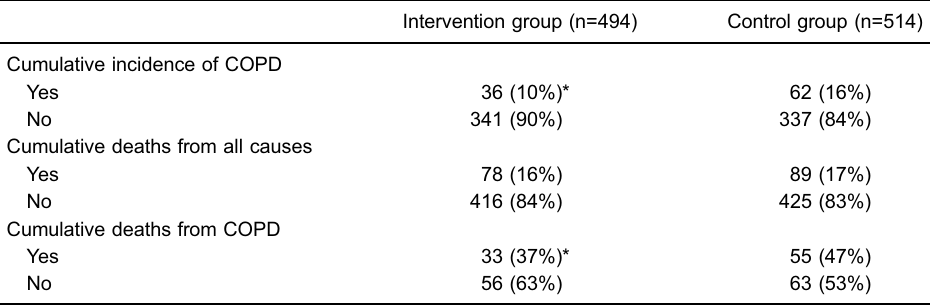
Table 3. Comparisons between the rates of occurrence and death of COPD in the intervention and control groups.